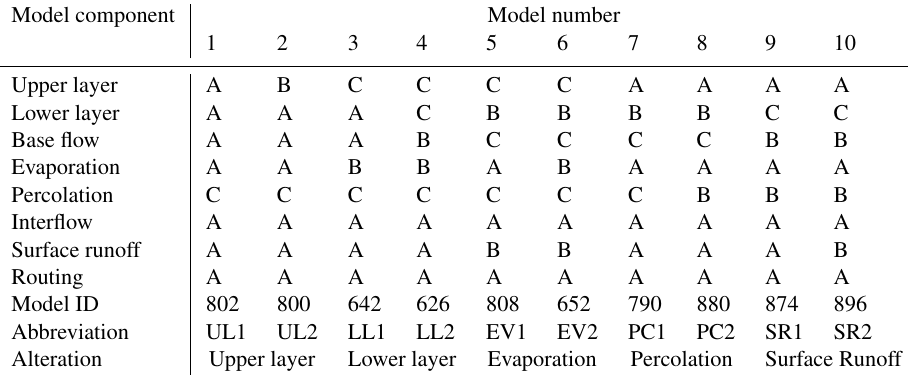
Table 1. The model structures that were employed in this study. Each letter refers to a specific hydrological process formulation as in Clark et al. (2008); the model IDs are described by Vitolo et al. (2015). The model abbreviations are related to the alteration in the model structure and are used throughout this